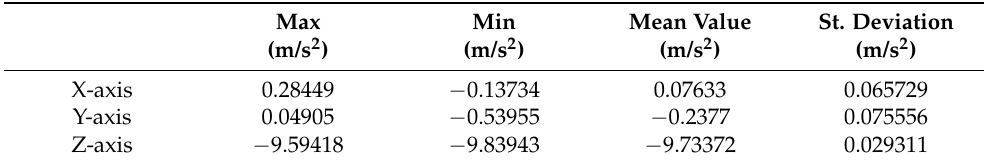
Table 4. Data from triaxial accelerometer in iNEMO inertial module.